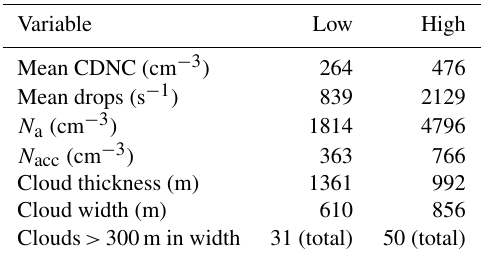
Table 3. Average values for low (L1, L2) and high (H1, H2) pollu- tion clouds for select variables from Table